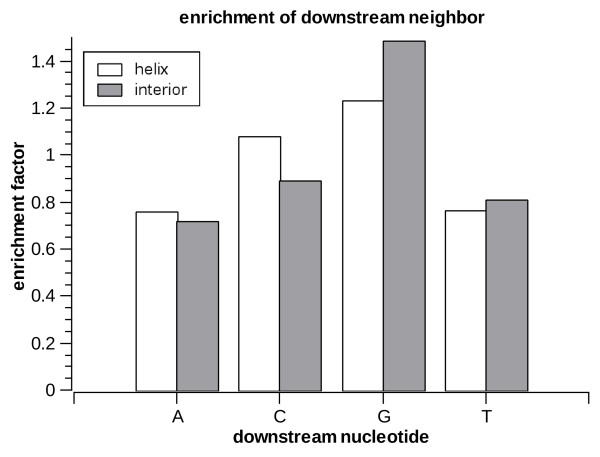
Enrichment factors for downstream nucleotide in helices and interior loops.